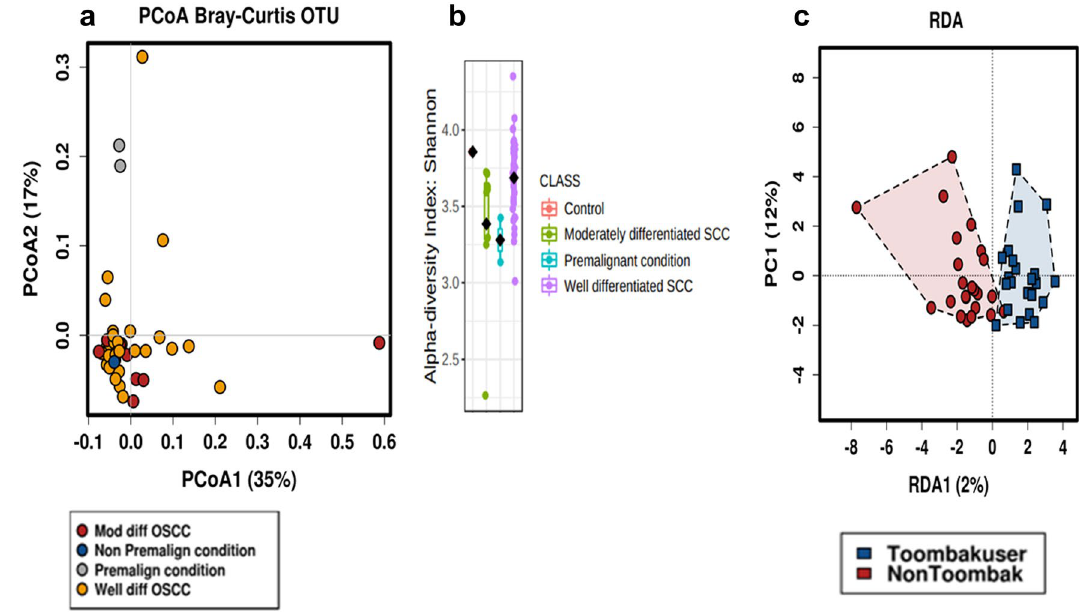
Figure 8. Premalignant and oral squamous cell carcinoma metagenomic profiles. ( a ) β-diversity of oral squamous cell carcinoma cancer samples from Sudanese participants utilising paraffin embedded blocks. Differentiation between premalignant and malignant samples may be observed. Malignant samples are further classified into moderate (n = 8) and well-differentiated OSCC (n = 35). ( b ) Shannon diversity ( p =